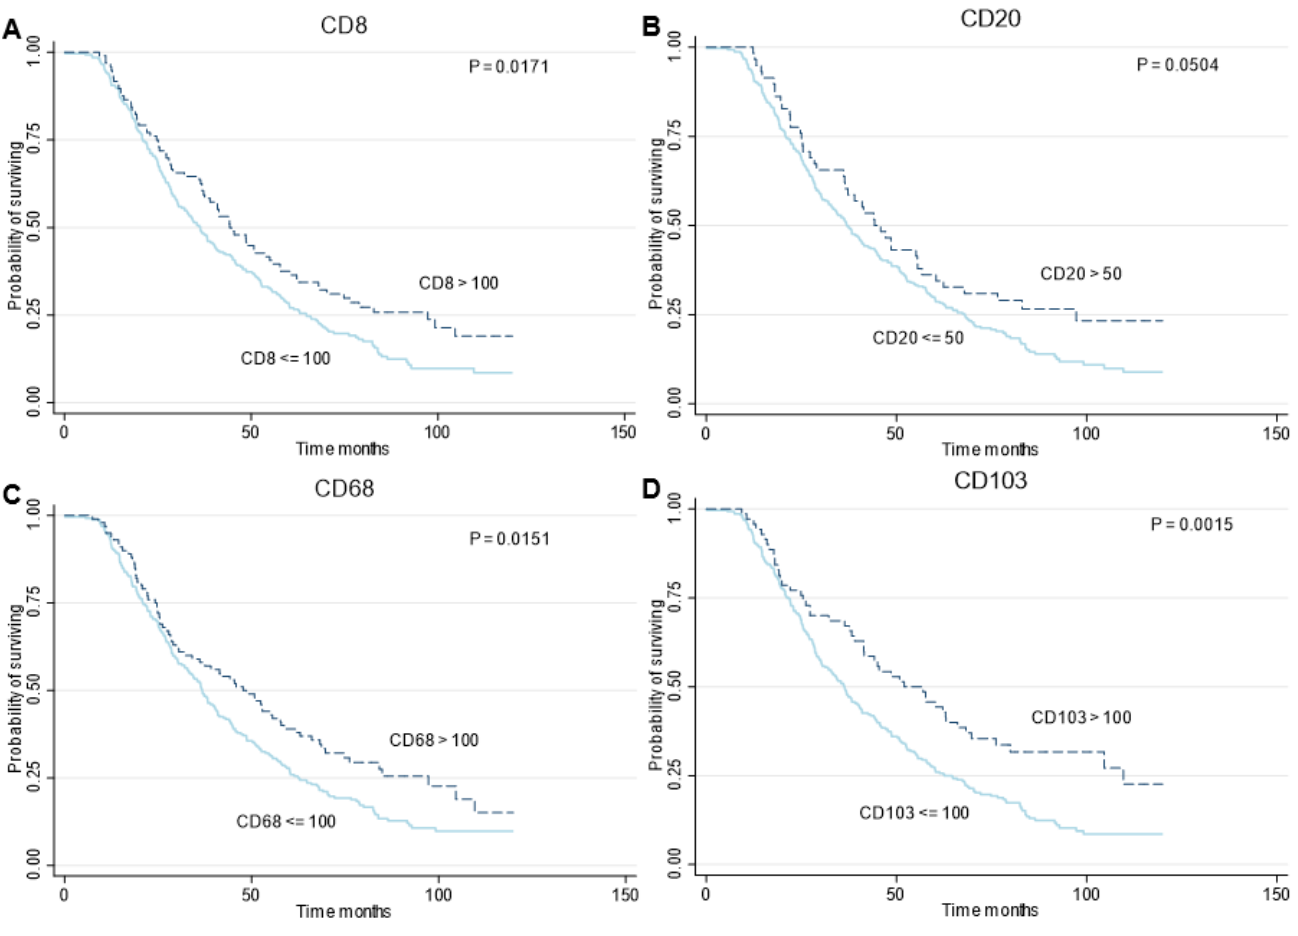
Figure 4. Survival analyses of patients with HGSOC, according to immune cell densities. Panels A to D show Kaplan–Meier curves for overall survival according to density of CD8 cells ( A ), CD20 ( B ), CD68 ( C ) and CD103 ( D ), respectively. p values were derived with the use of the log-rank statistic. Table 4. Overall survival analysis, immune cell composition.